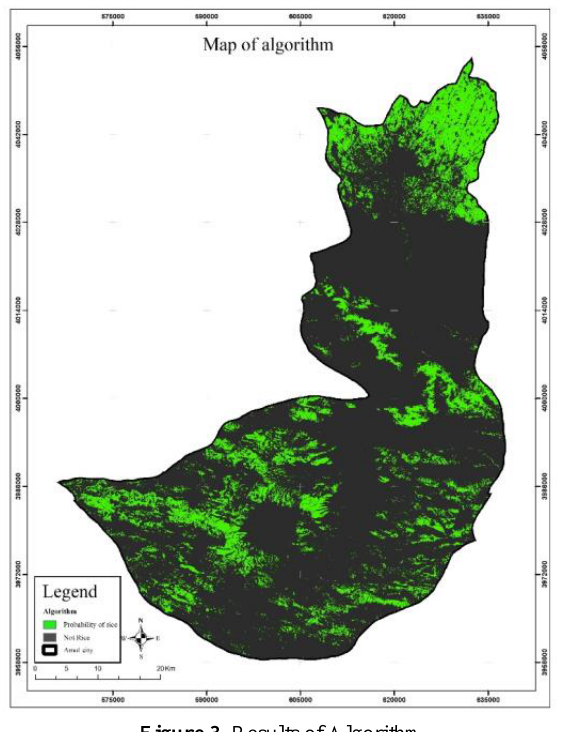
Figure 3 . Results of Algorithm